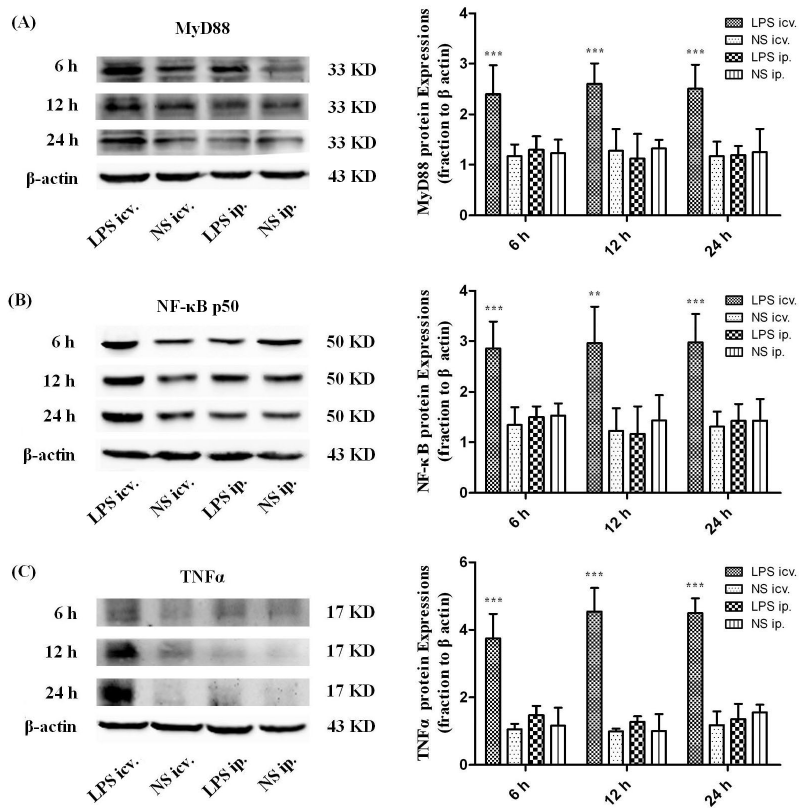
transcription factor kappa-B (NF- κ B) p50 and tumor necrosis factor alpha (TNF α ) 6, 12 and 24 h after icv. or ip. injection of LPS or NS in the P1 rat brain. ( A ) Representative picture of the immunoblot of MyD88 in the P1 rat brain after icv. or ip. injection of LPS or NS at 3 time points, and the graph of statistical analysis of the immunoblot of MyD88 in the brain in various groups. *** p < 0.001, compared with the central NS injection group; ( B ) Representative picture of the immunoblot of NF- κ B p50 in the P1 rat brain after icv. or ip. injection of LPS or NS at 3 time points, and the graph of statistical analysis of the immunoblot of NF- κ B p50 in the brain in various groups. ** p < 0.01 and *** p < 0.001, compared with the central NS injection group; ( C ) Representative picture of the immunoblot of TNF α in the P1 rat brain after icv. or ip. injection of LPS or NS at 3 time points, and the graph of statistical analysis of the immunoblot of TNF α in the brain in various groups. *** p < 0.001, compared with the central NS injection